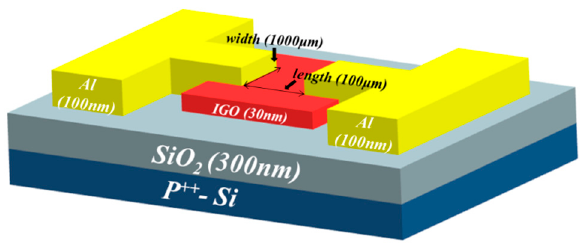
Figure 1. Schematic of IGO TFTs.